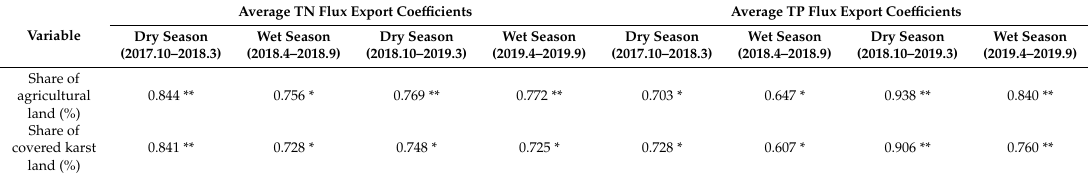
Table 6. The Pearson correlation coe ffi cient between the average nutrient export coe ffi cients and the share of agricultural land in the dry seasons and wet